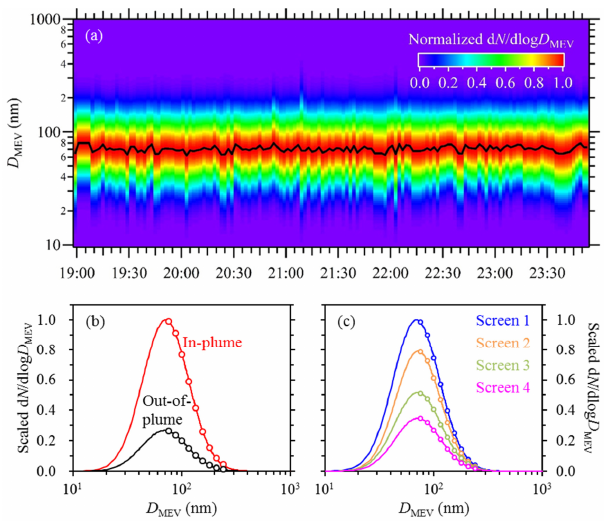
Figure 8. (a) Time-resolved rBC number size distribution observed during the transformation flight F_9/4, (b) comparison of rBC num- ber size distributions between typical in- and out-of-plume condi- tions, and (c) comparison of in-plume rBC number size distributions among successive flight screens. Scaling of out-of-plume rBC size distribution in (b) and scaling of rBC size distributions for screens 2 to 4 in (c) are explained in the